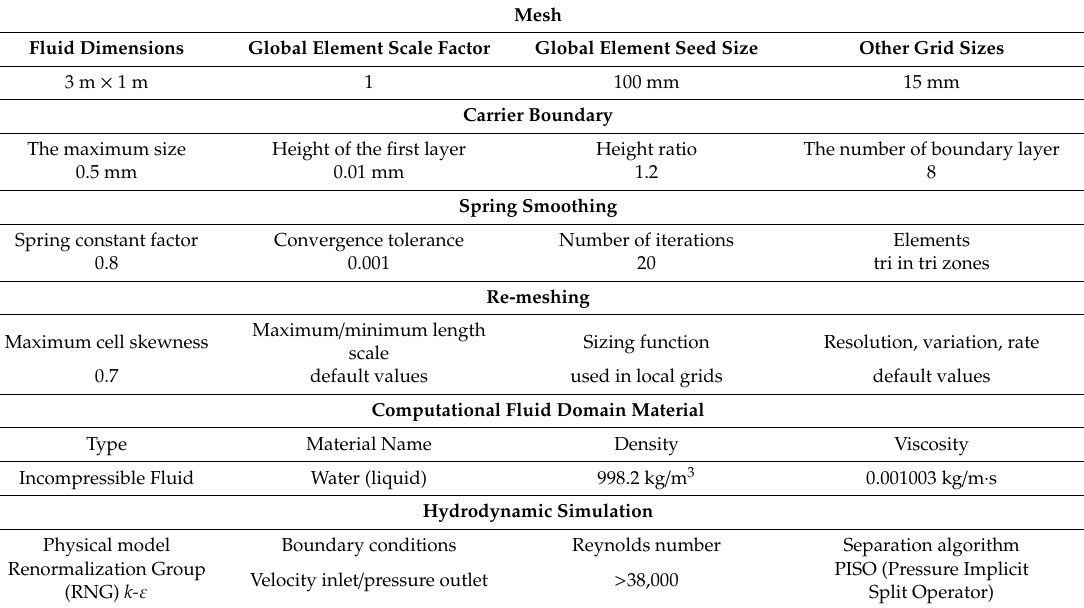
Figure 4. Carrier model and calculated fluid domain. Table 1. Basic parameters of the